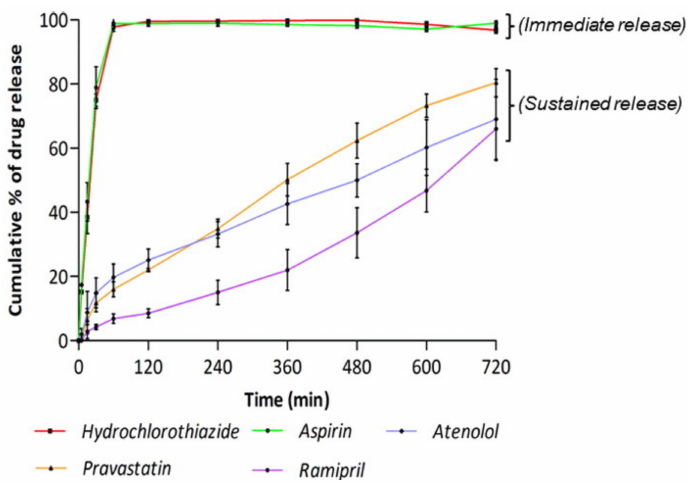
Figure 5. The drug-release profile of each drug from the compartments in the polypill in vitro